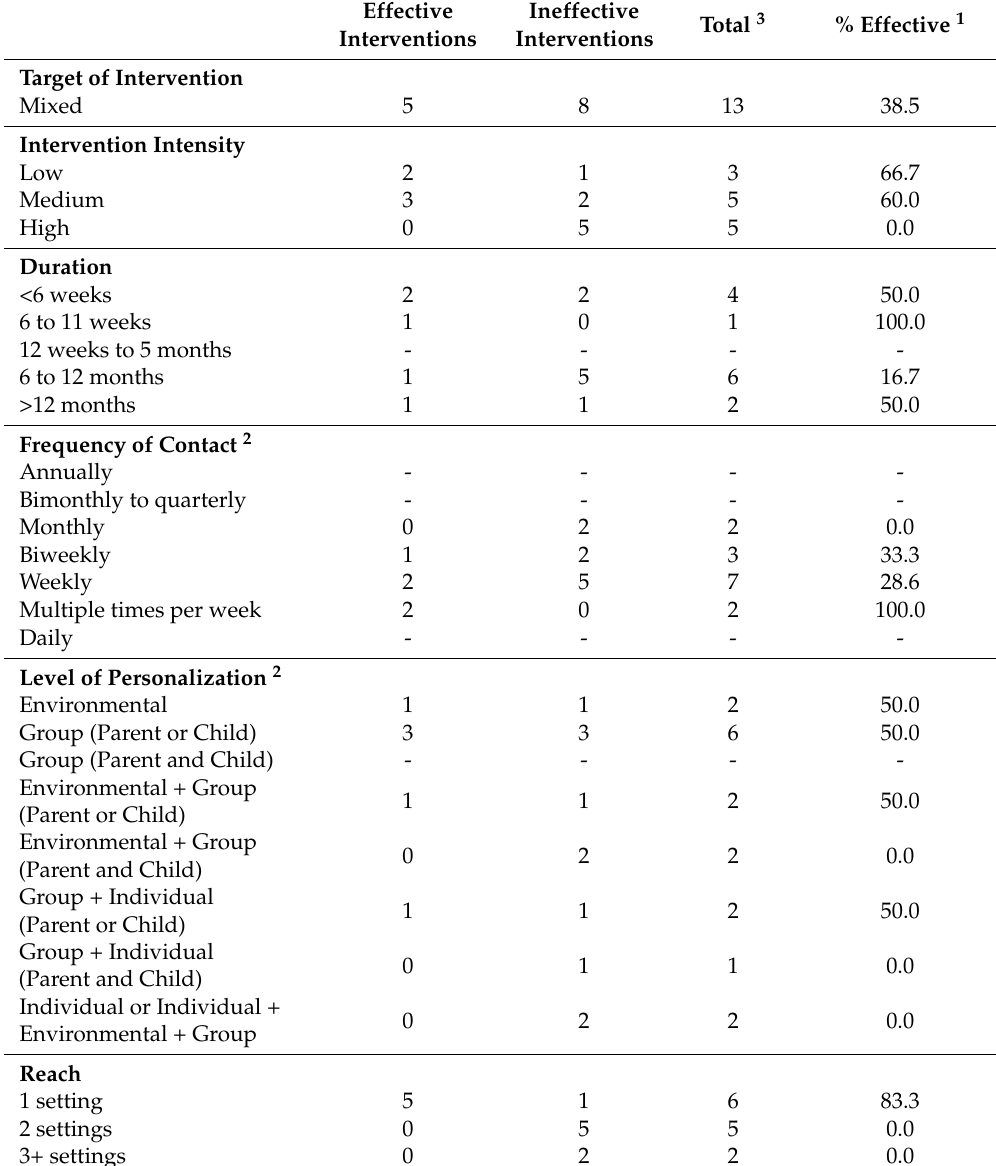
Table 2. Intervention characteristics and intensity rating categories associated with intervention effectiveness ( n =